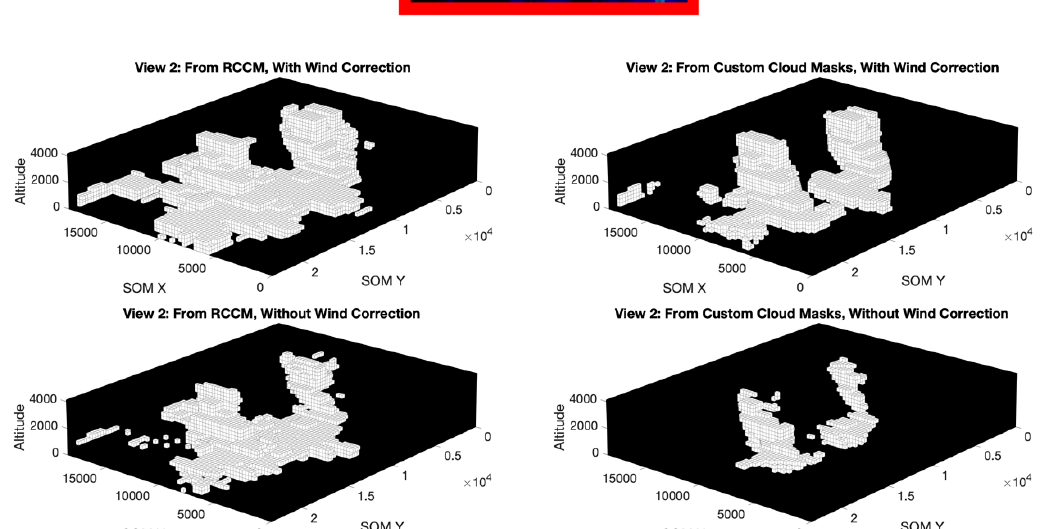
Figure 13. Same as Figure 9, but for the reconstruction region in Orbit 1181 Block 91.